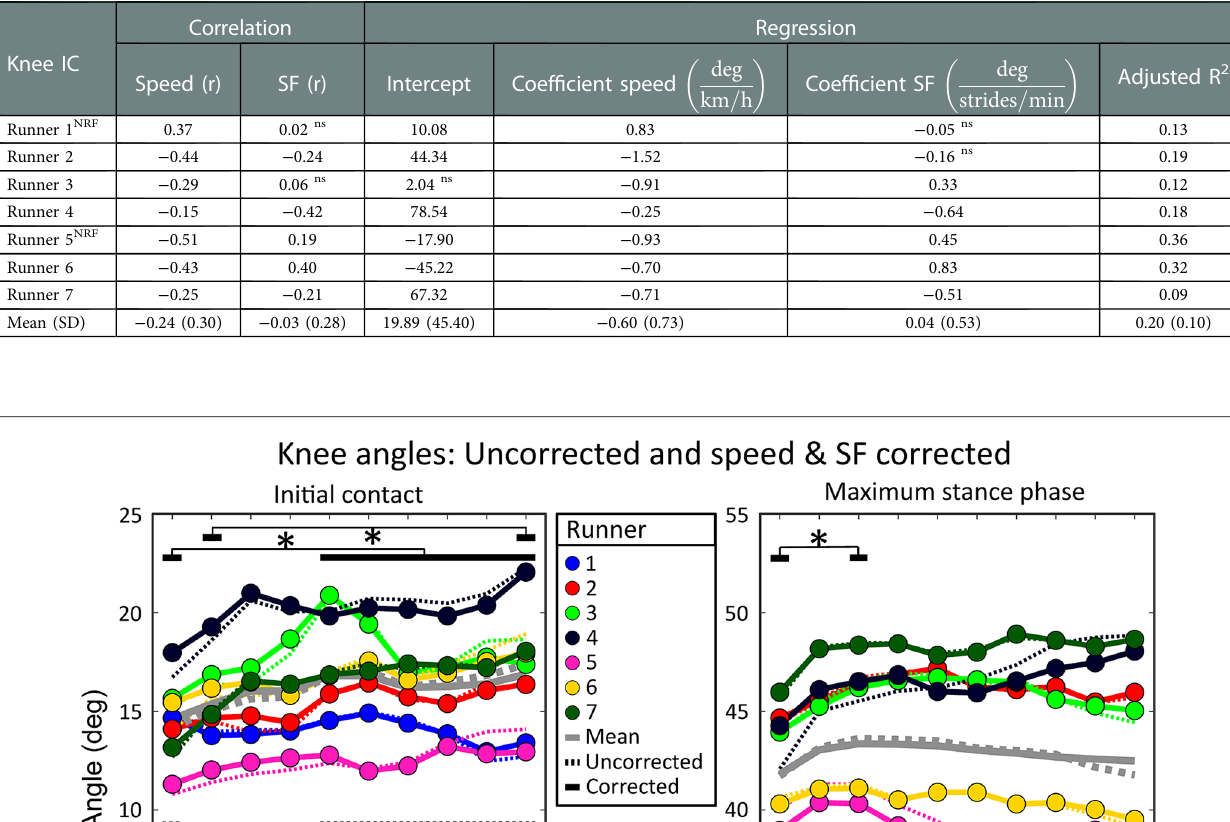
TABLE 2 Left side of table: individual correlations of knee angles at initial contact (IC) with speed and stride frequency (SF). Right side of table: Individual regression equations to predict knee angles at IC based on speed and stride frequency together with the adjusted R-squared value (i.e., explained variance of regression equation). r, Pearson ’ s correlation coef fi cient; SD, standard deviation; ns, non-signi fi cant fi nding; NRF, non-rearfoot striking subject.